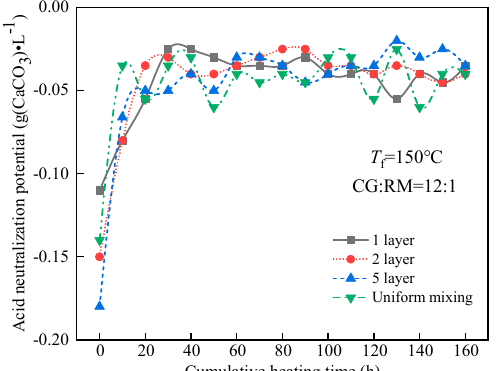
Figure 11. Variations of ANP of co-disposal leaching solution with different storage methods.